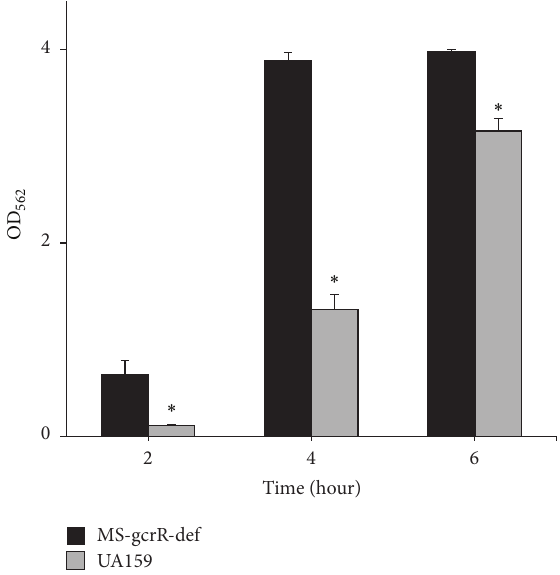
Figure 2: The adhesion ability of Streptococcus mutans UA159 as well as the MS-gcrR-def was determined based on the absorbance of the cells on the plate. ∗ Significant differences of adhesion between UA159 and MS-gcrR-def ( 𝑃 < 0.05 ) were found, while there was no variance in cell